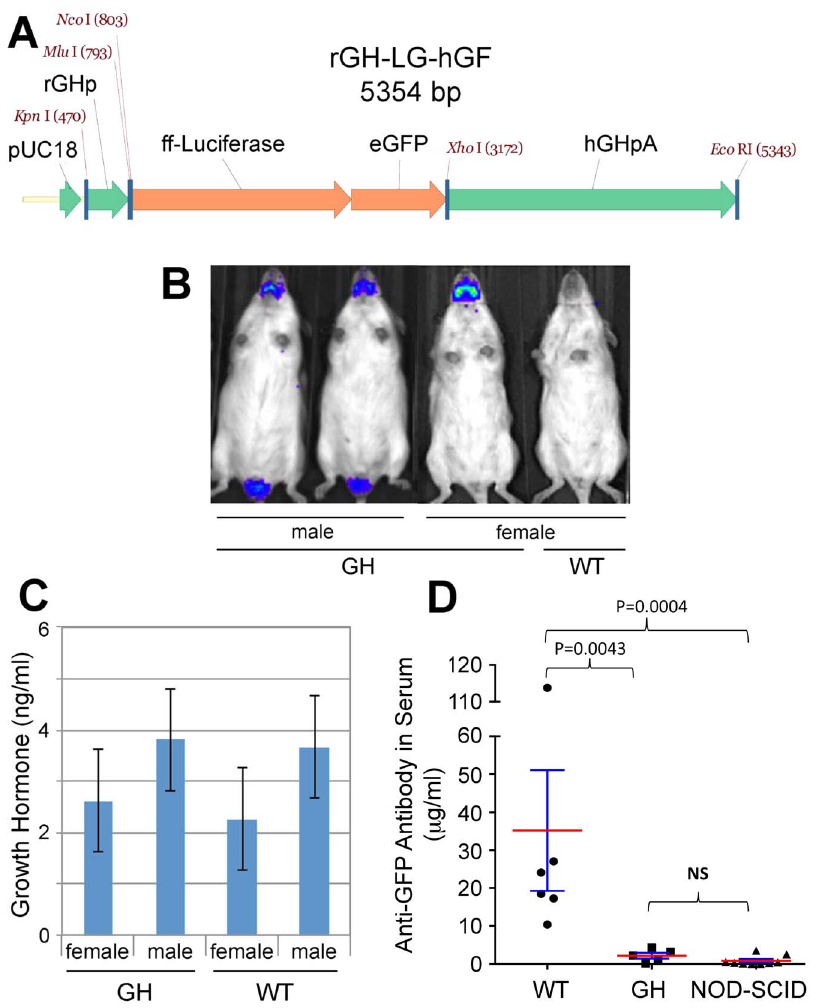
Figure 2. Generation of the rGH-ffLuc-eGFP (‘‘Glowing Head’’) genetically engineered mouse. A , Structure of the expression vector for generation of Glowing Head (GH) transgenic mice. Expression of a firefly luciferase-eGFP fusion gene (ffLuc-eGFP) was targeted to the mouse anterior pituitary gland by using the rat growth hormone promoter (rGH) and human growth hormone gene sequences, which include a polyadenylylation site (hGHpA) 20 . B , Optical expression pattern of transgene in GH mice as visualized by BL imaging. Reporter activity was detected in the anterior pituitary gland of both genders and the testes of male mice. C , Serum levels of growth hormone from age-matched GH mice and wildtype (WT) c-Brd mice was assessed by ELISA (mean 6 SE). Blood was withdrawn at the same time of day. No significant differences in circulating growth hormone levels between the GH and WT mice were found. D , ffLuc-eGFP-labeled LLC tumors were subcutaneously transplanted into WT, GH, and NOD-SCID mice. Blood was withdrawn to prepare sera when tumors reached 500 mm 3 , and the serum levels of anti-GFP antibody were analyzed by ELISA. The levels of anti-GFP antibody in WT mice are significantly higher than those in GH and NOD-SCID mice (p , 0.005), but no difference was found between those in GH and NOD-SCID mice (p=0.19). The sera from healthy mice without tumor transplantation served as controls to define zero